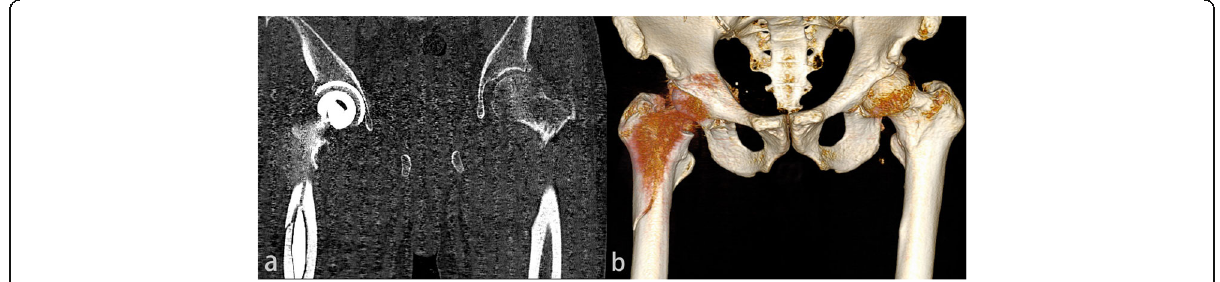
Fig. 2 a-b Computed tomography scan and three-dimensional reconstruction of the right hip in postoperative day 1 showed the distal extension of the fracture line down the lateral cortex; this leads to destabilization of the stem because the lateral buttress is lost